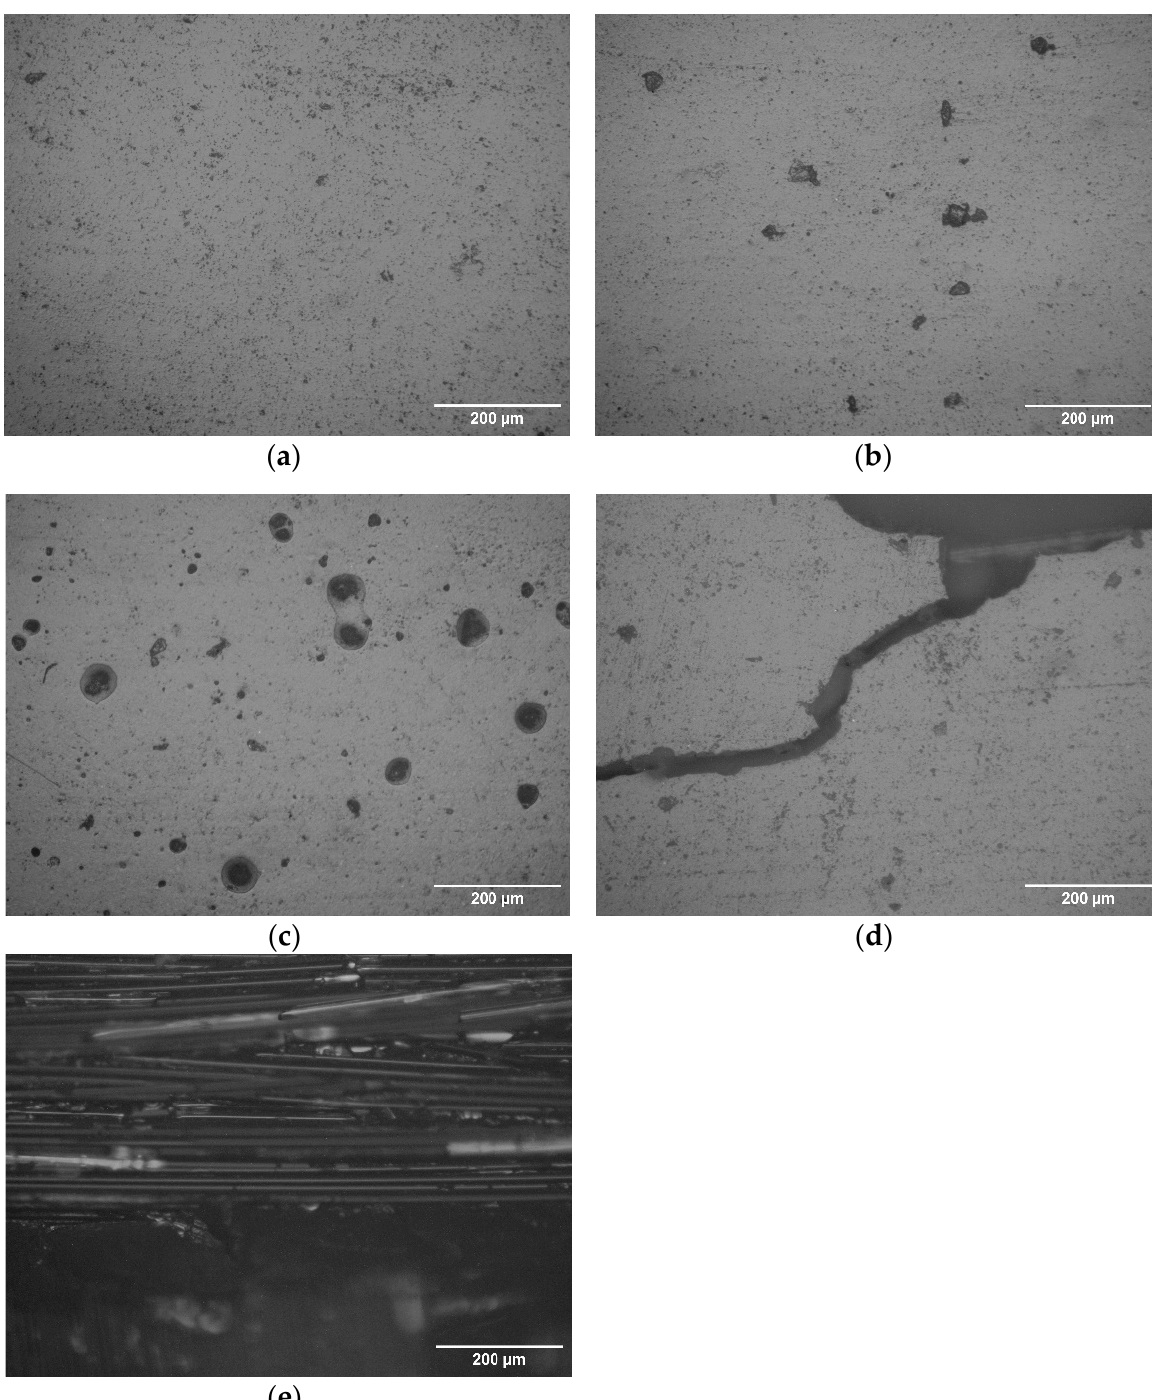
Figure 10. Microcopy image of representative sample with coating B at ( a ) stage 1; ( b ) stage 2; ( c ) stage 3; ( d ) stage 4; ( e ) stage 5. each erosion